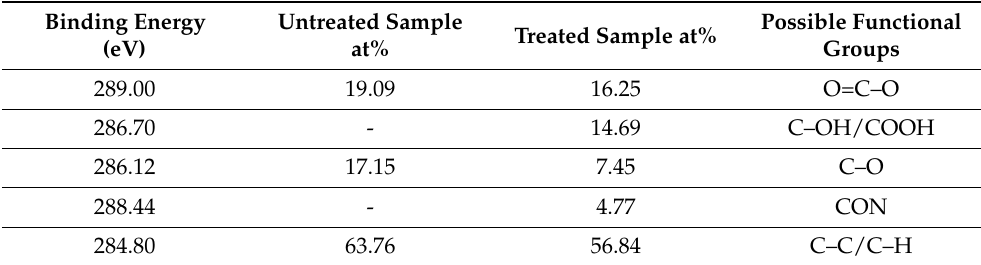
Table 2. Changes of chemical components of C 1s